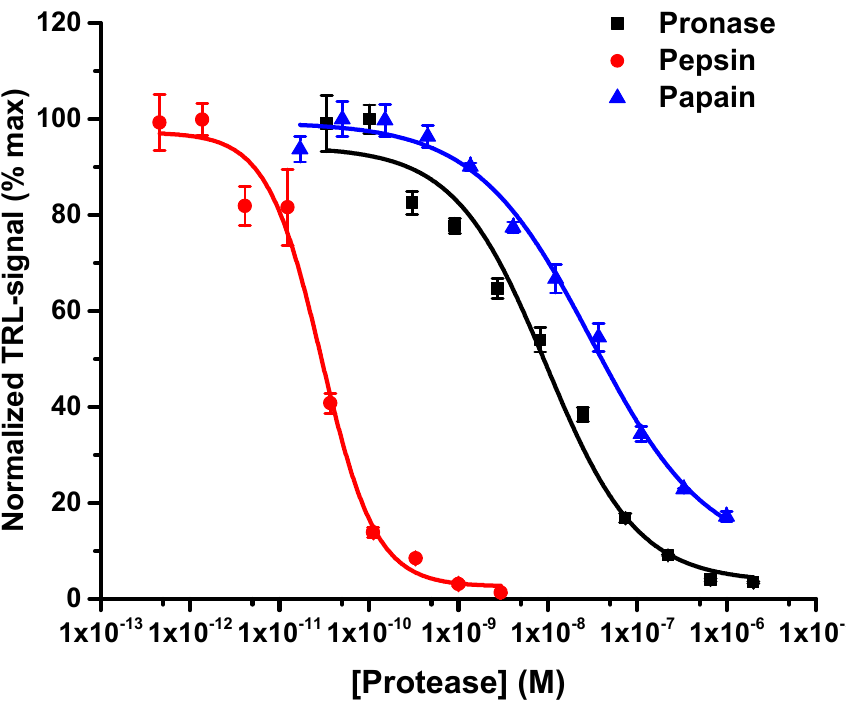
Int. J. Mol. Sci. 2021 , 22 , 6362 Figure 2. Protease titrations with BSA as the digested substrate. Pronase (black, 0–2 µ M), pepsin (red, 0–3 nM), and papain (blue, 0–1 µ M) were mixed with 10 nM BSA, and reactions were incubated at 37 ◦ C for 30 min. Thereafter the protein-probe solution was added, and the TRL-signals were monitored at RT. The EC 50 values for pronase, pepsin, and papain were 8.6 ± 2.7, 0.03 ± 0.01, and 31.0 ± 8.5 nM, respectively. The S/B ratios of non-digested and digested BSA were 11.1, 21.1, and 4.8 for pronase, pepsin, and papain, respectively. Data represent mean ± SD ( n = 3).